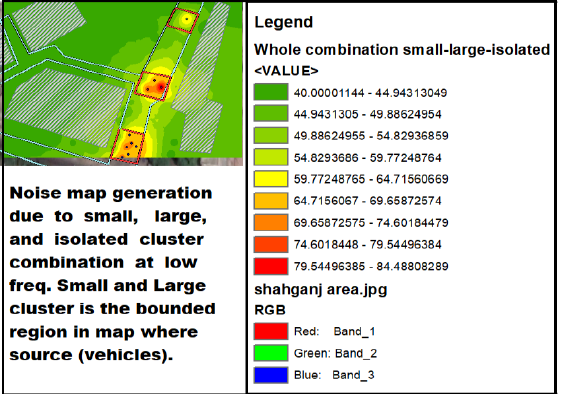
Figure 15. Noise map for a combination of the small, large, and isolated clusters at low freq. 31.5Hz.